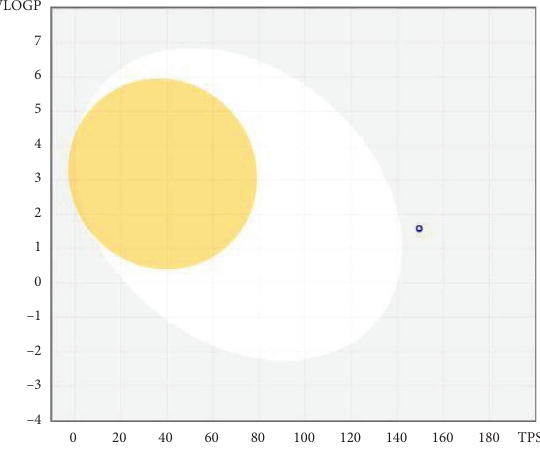
Figure 4: Boiled graph representation of